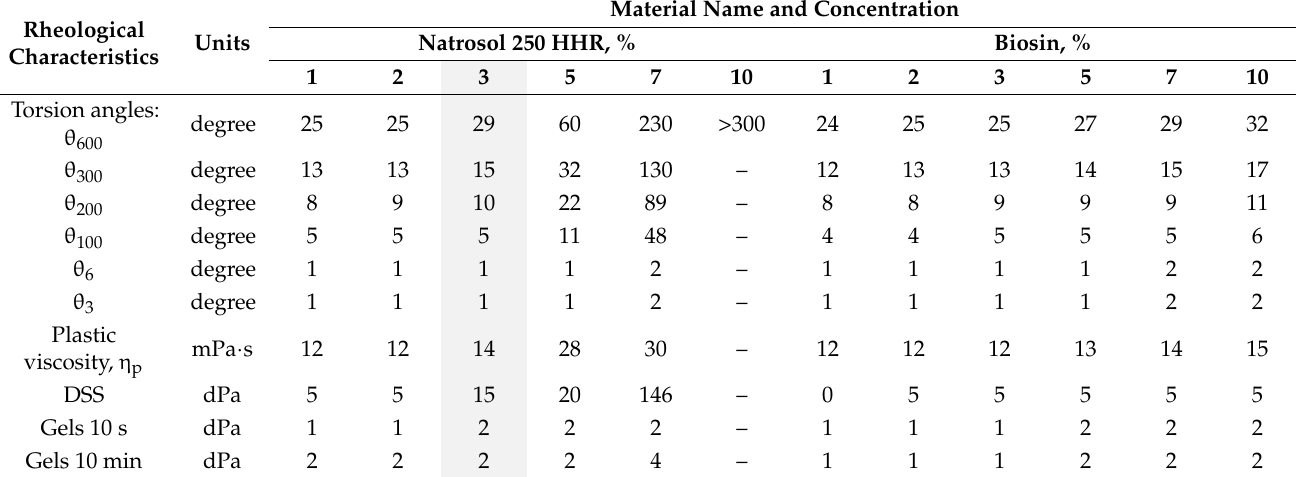
Table 3. Study of the effect of polymer concentration on the structural and rheological characteristics of brine under normal